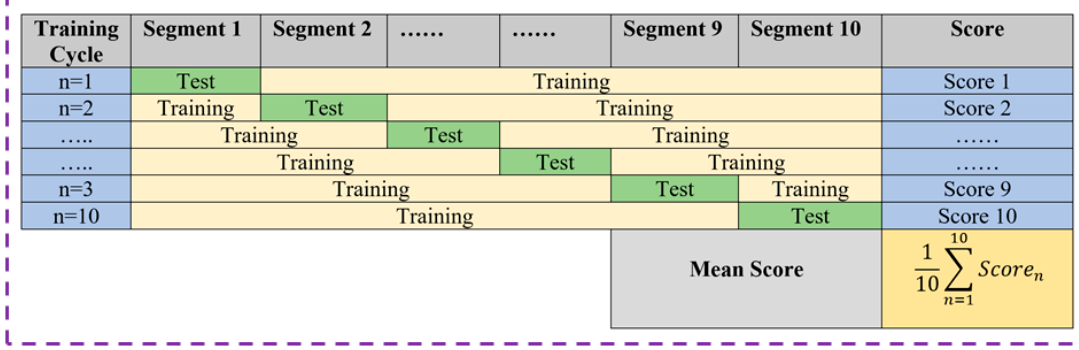
Figure 6. Data splitting by k -fold